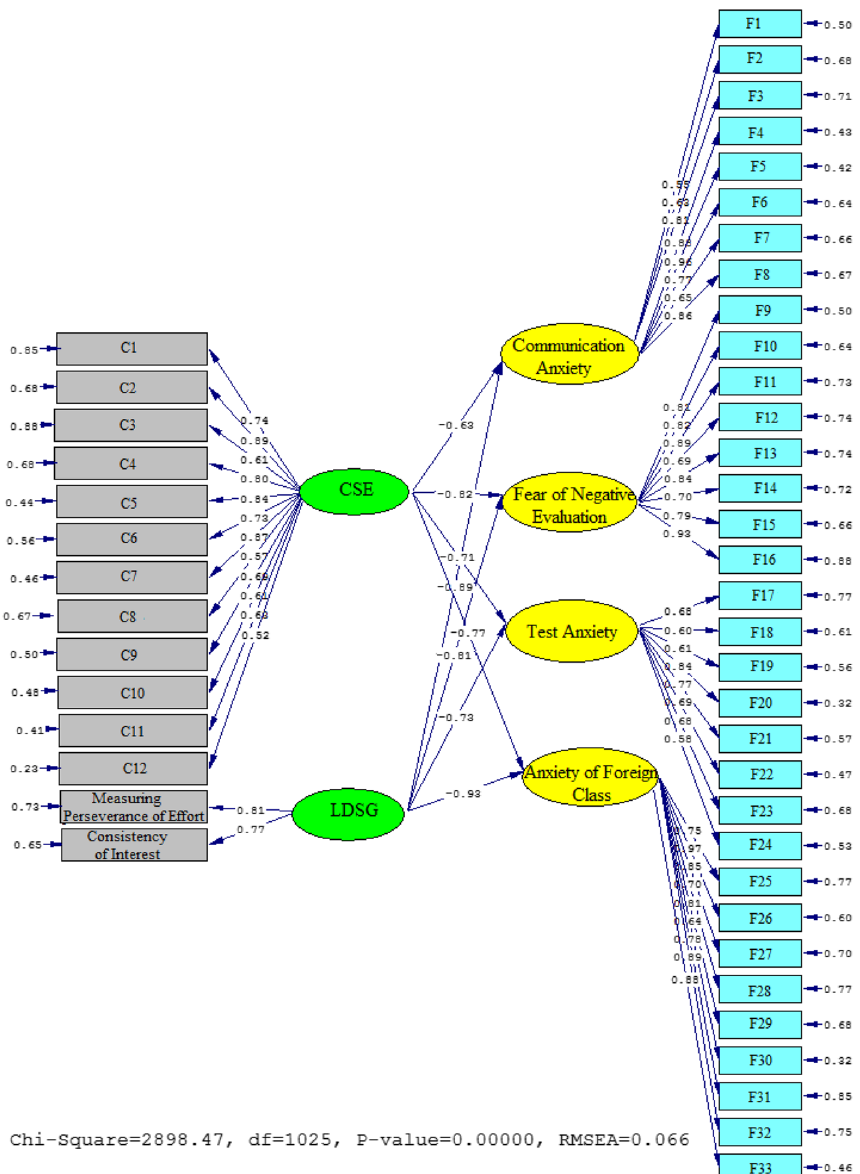
Fig. 4 Schematic representation of path coefficient values for the influential role of L2-grit, CSA, and FLA (model